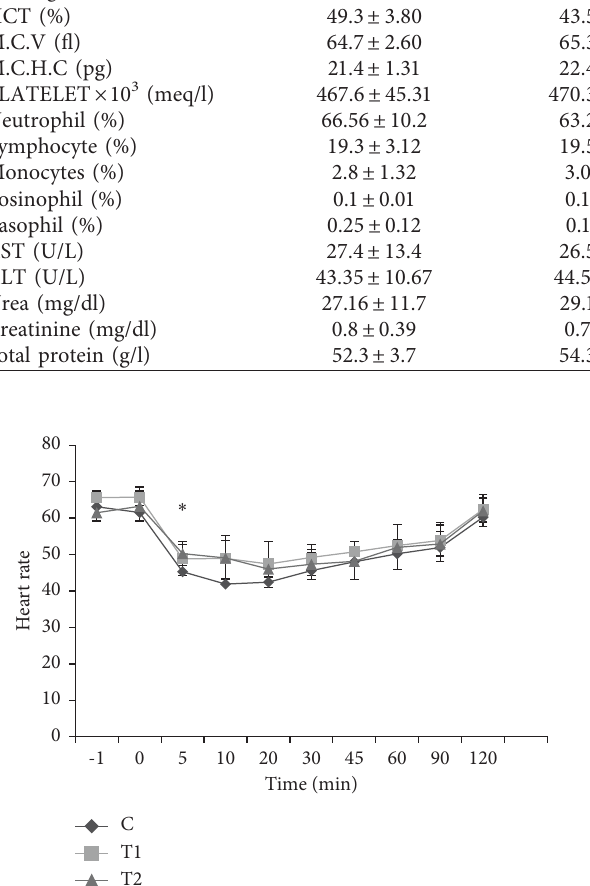
Figure 1: Changes in heart rate in the studied groups before and after anesthesia. All values are presented as the mean ± standard error of the mean (mean ± SEM). ∗ is a significant difference within the intragroup. C: control group. T1: treatment group 1. T2: treatment group